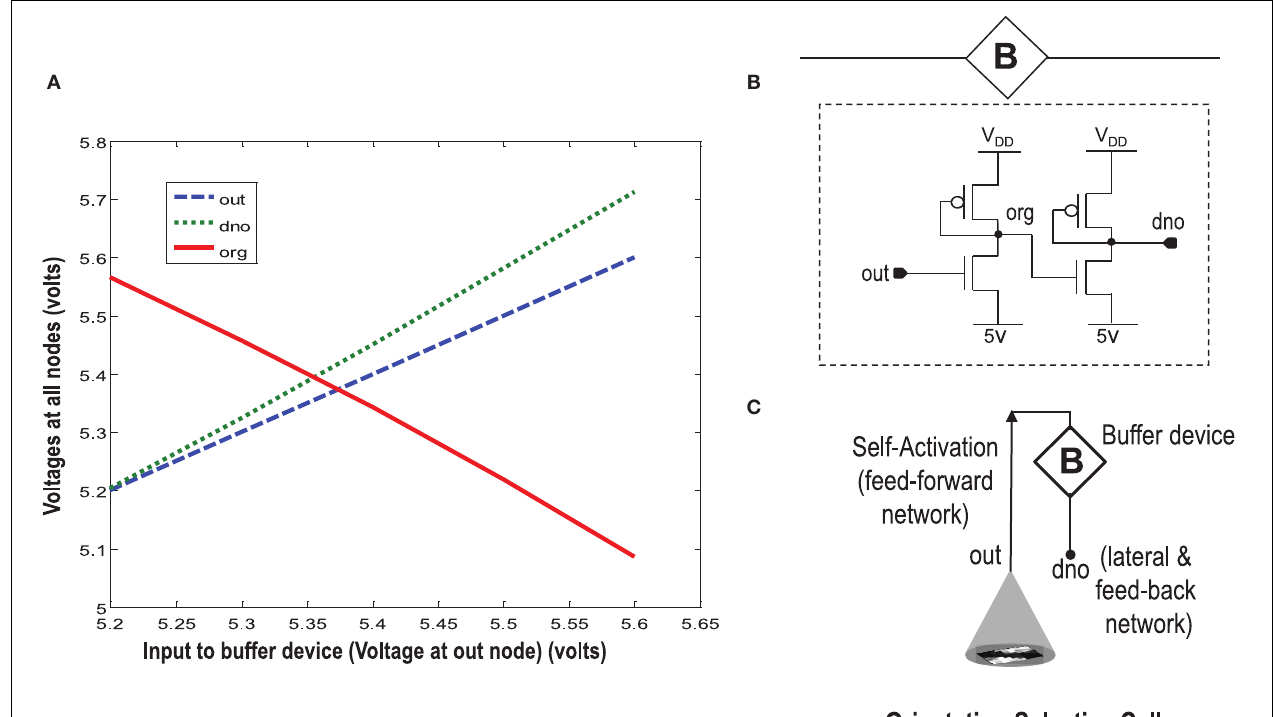
FIGURE 11 | In order to isolate the OR cell output (out) which conveys the self-activation of the cell, from the diffusion node (dno) at which other orientation cells connect and to prevent loading of node out, a buffer device is created. (A) Shows the characteristic response of the